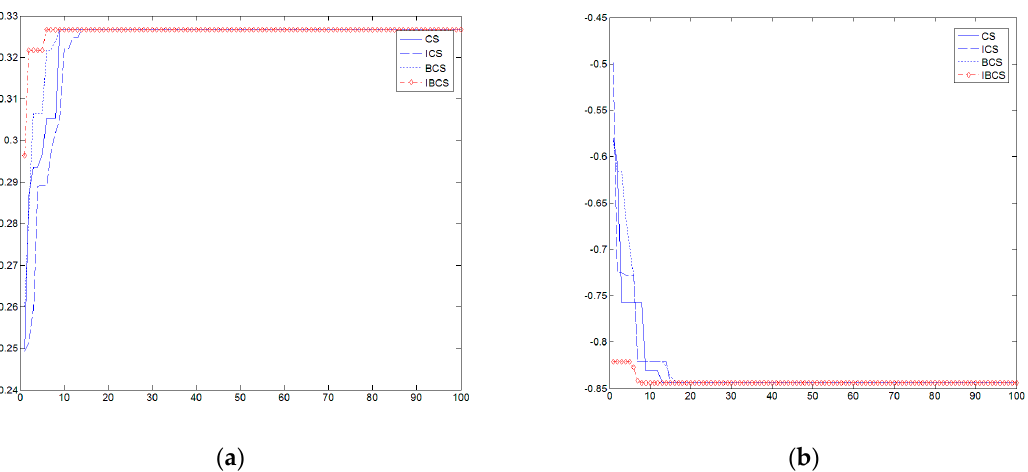
Figure 10. Comparison of the convergence results of the single objective optimization in the process of EDM; ( a ) for MRR ; ( b ) for Ra .